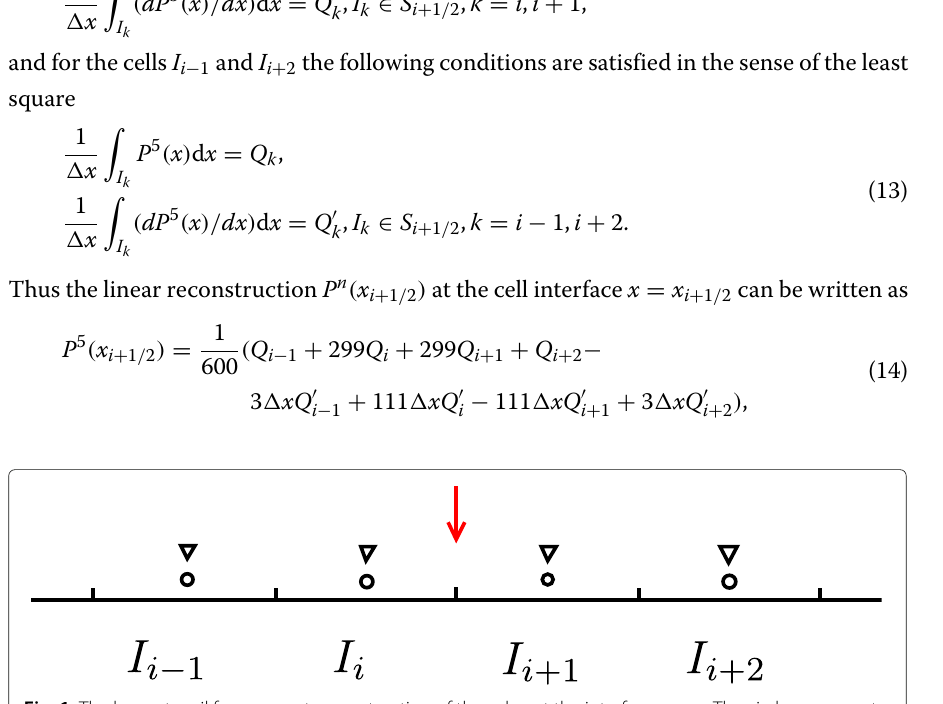
Fig. 1 The large stencil for compact reconstruction of the value at the interface x i + 1 / 2 . The circles represent cell averages, and the gradients represent averaged